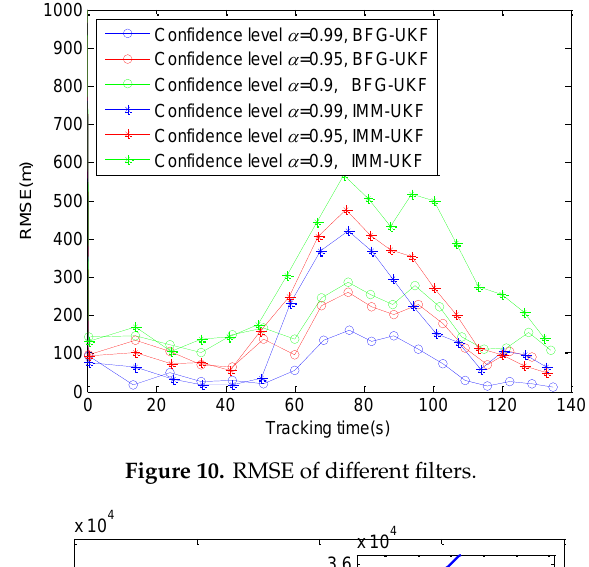
Figure 10. RMSE of different filters.